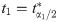
Left panel—CET point estimates and confidence intervals.Point estimates and confidence intervals of thirteen possible results from two-sample testing of normally distributed data are presented alongside their corresponding conclusions. Let n = 90, Δ = 0.5, α1 = 0.05 and α2 = 0.10. Black points indicate point estimates; blue lines (wider intervals) represent (1-α1)% confidence intervals; and orange lines (shorter intervals) represent (1-2α2)% confidence intervals. Right panel- Rejection regions. Let t1=tα1/2*, t2=tα2*. The values of μ^d=x¯1-x¯2 (on the x-axis) and s*=sp(1/n1+1/n2) (on the y-axis) are obtained from the data. The three conclusions, positive, negative, inconclusive correspond to the three areas shaded in green, blue and red respectively. The black lettered points correspond to the thirteen scenarios on the left panel.